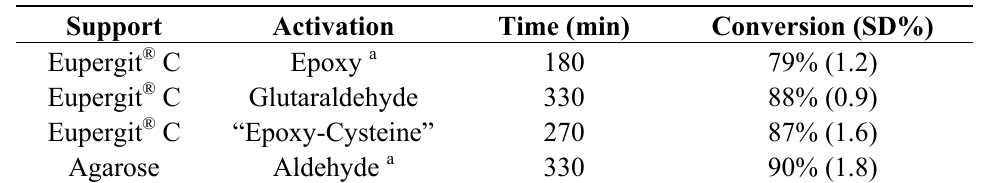
Table 1. Percentage of conversion obtained in the synthesis of Cefazolin catalyzed by different PGA preparations (see also Scheme 1).